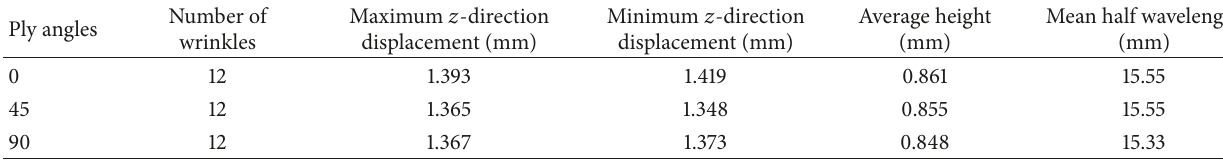
Table 12: The geometrical features of different ply angles laminated membranes.